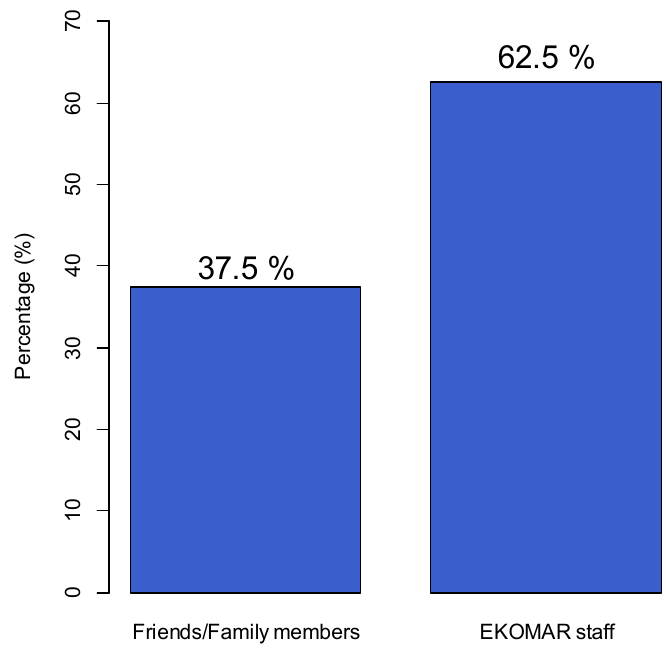
Figure 11. How respondents found out about the RE project at EKOMAR (Survey 1). Table 5. Reasons why Mersing is a suitable region for wind and solar energy development.